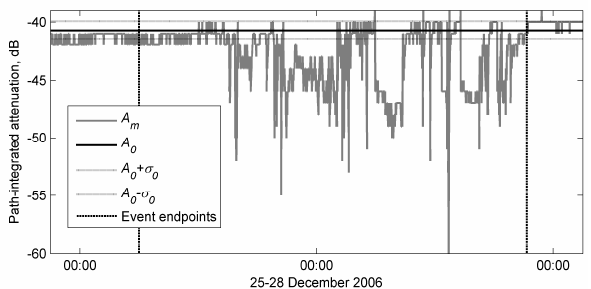
Fig. 1. An example of the baseline attenuation determination (23.27GHz, 2.19km). A M is the measured attenuation, A 0 is the Figure 1. An example of the baseline attenuation determination (23.27 GHz, 2.19 km). A M is 3 estimated baseline, and σ 0 is RMSE of A 0 . Event endpoints, defin- the measured attenuation, A 0 is the estimated baseline, and 0 σ is RMSE of A 0 . Event 4 ing the beginning and the end of the rainstorm, are determined ac- endpoints, defining the beginning and the end of the rainstorm, are determined according to 5 cording to the nearby Switch Ramle the nearby Switch Ramle gauge. 6